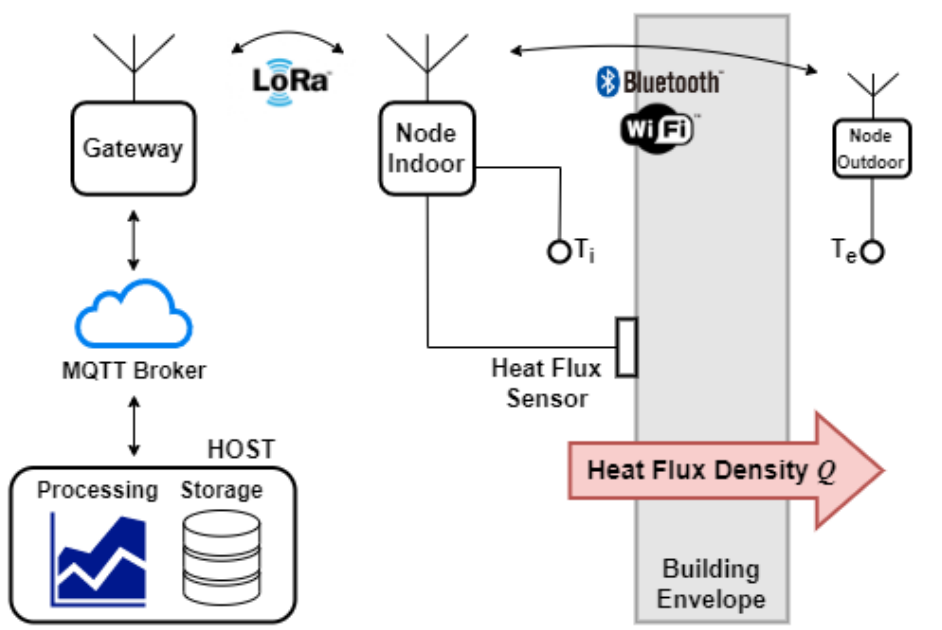
Figure 1. In situ U-value measurement setup for an average method according to ISO9869:2014 and remote data acquisition based on LoRaWAN network and MQTT